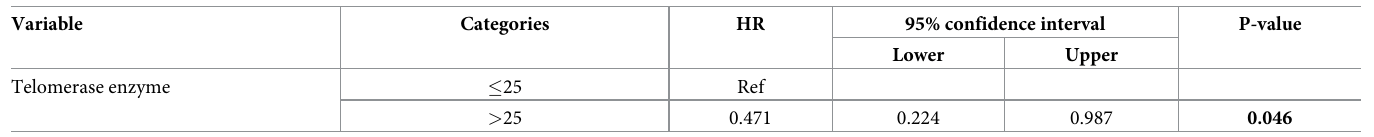
PLOS ONE | https://doi.org/10.1371/journal.pone.0237477 August 13,